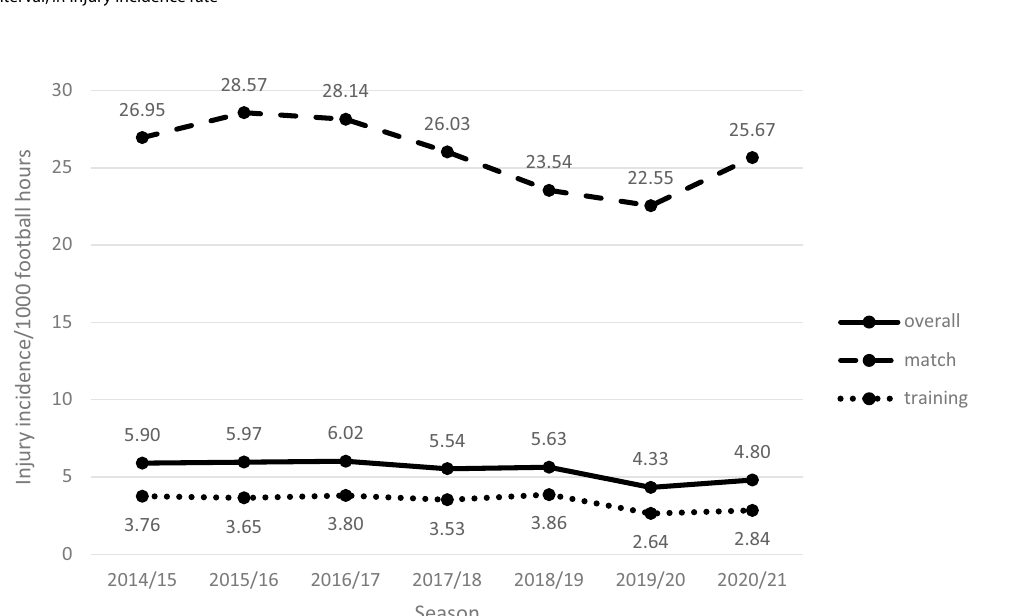
Fig. 1 Time trends—injury incidence rates per 1000 football hours according to match, training, and the overall number of